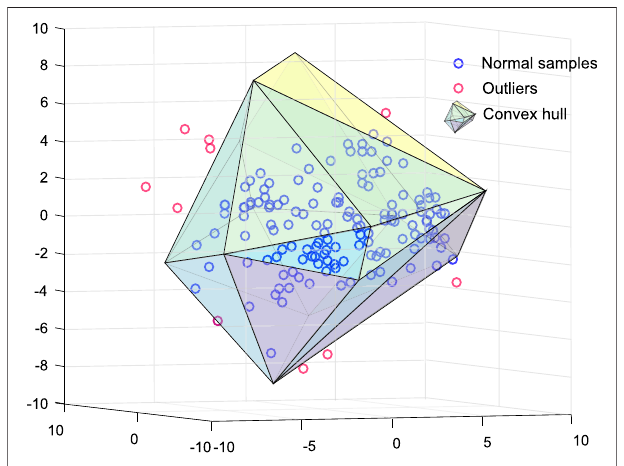
FIGURE 7 | APE technique using the approximate 2D convex